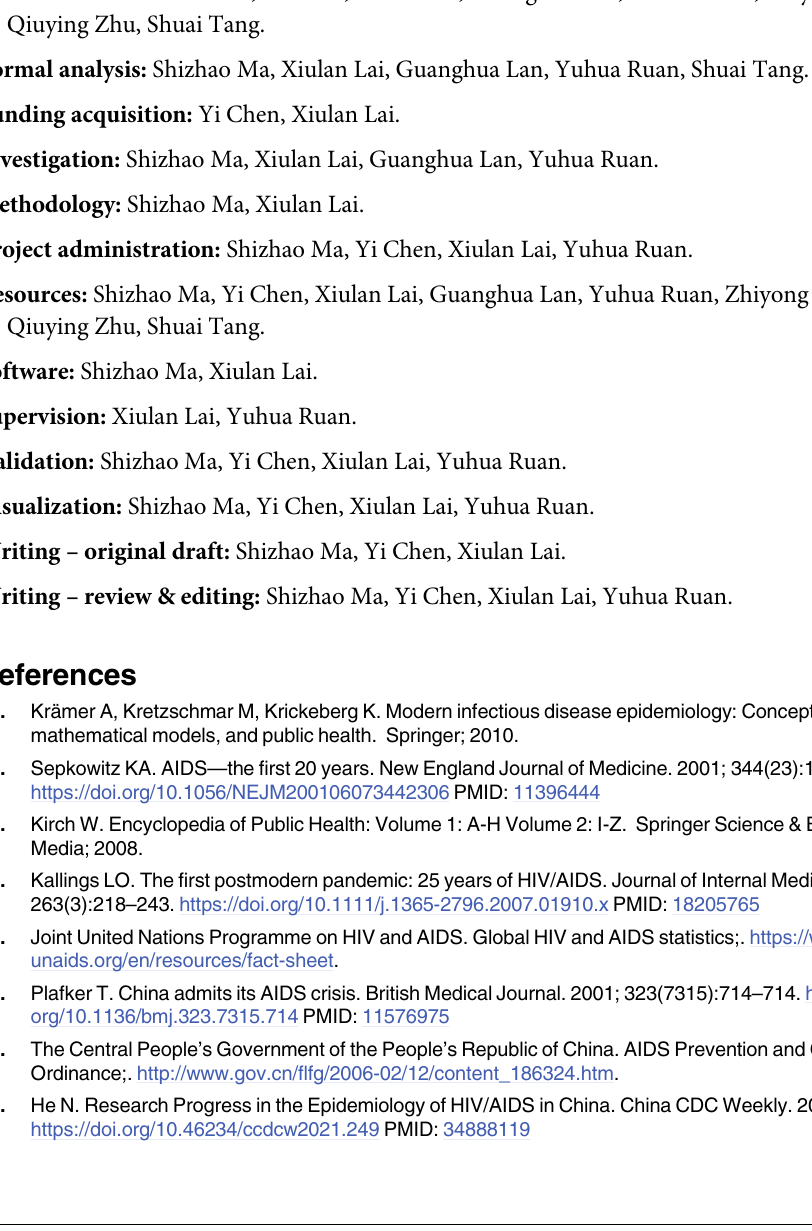
S1 Table. HIV/AIDS surveillance